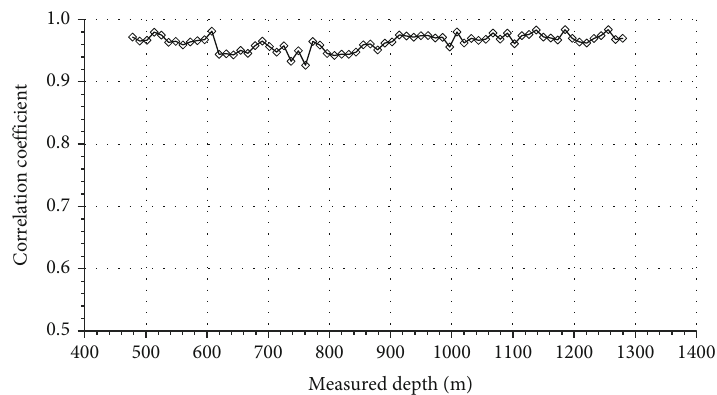
Figure 7: Correlation coe ffi cients regressed by temperature fall-o ff interpretation.